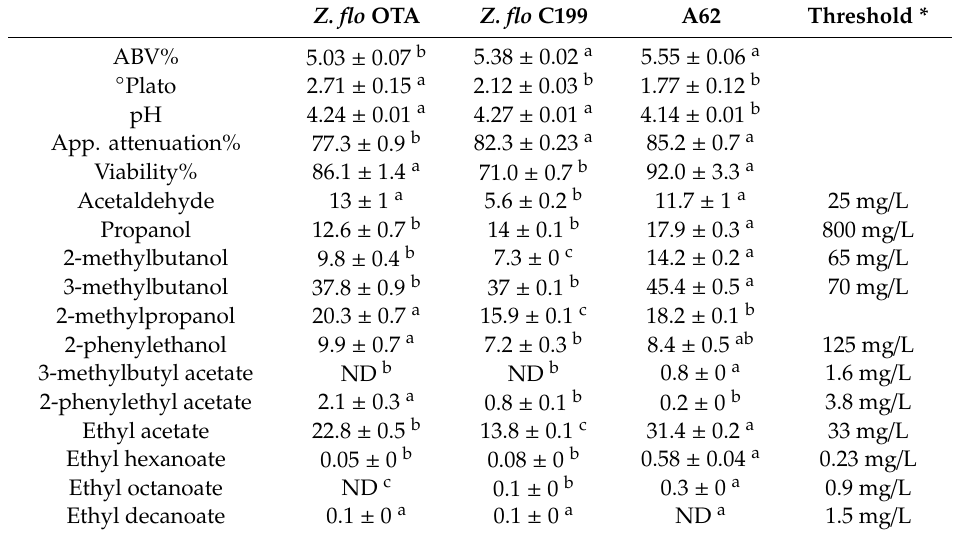
Table 2. Results of 2 L-scale fermentations in 12 ◦ P wort at 20 ◦ C. Volatile aroma values are all expressed as mg / L.